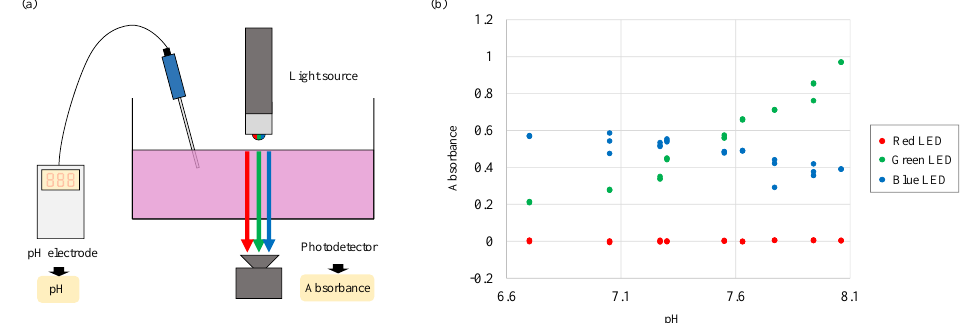
Figure A1. Experiments for the absorbance of lights in different pH solutions. ( a ) The experimental setup; ( b ) The result shows that the absorbance of the green light is affected by pH the most.